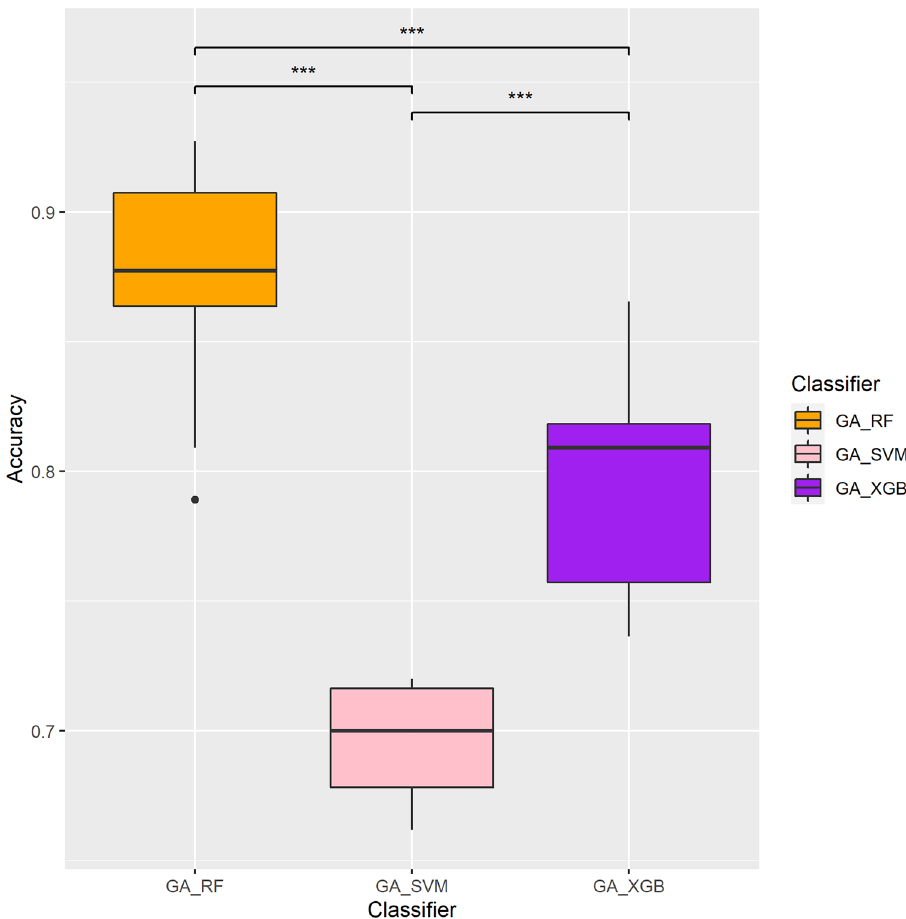
Figure 3. Performance evaluations and comparisons of different GA-incorporated models in predicting MGMT methylation statuses. Y-axis represents accuracy. Statistical significances evaluated by Kolmogorov– Smirnov test are represented by stars, in which three stars (***) indicate p <